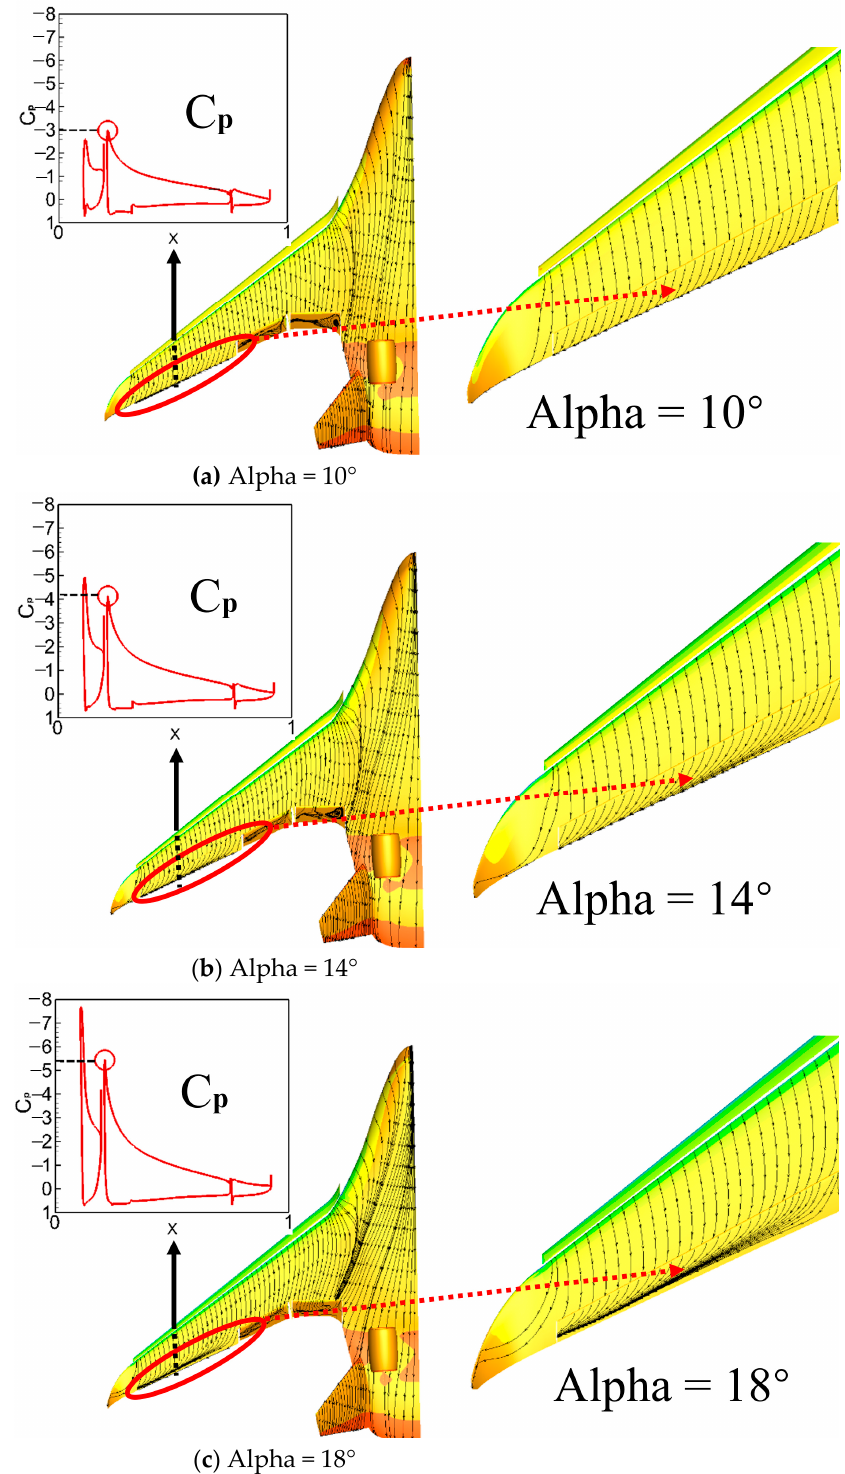
Figure 10. Upper surface limiting streamlines, the local pressure distribution of the high lift config- uration.